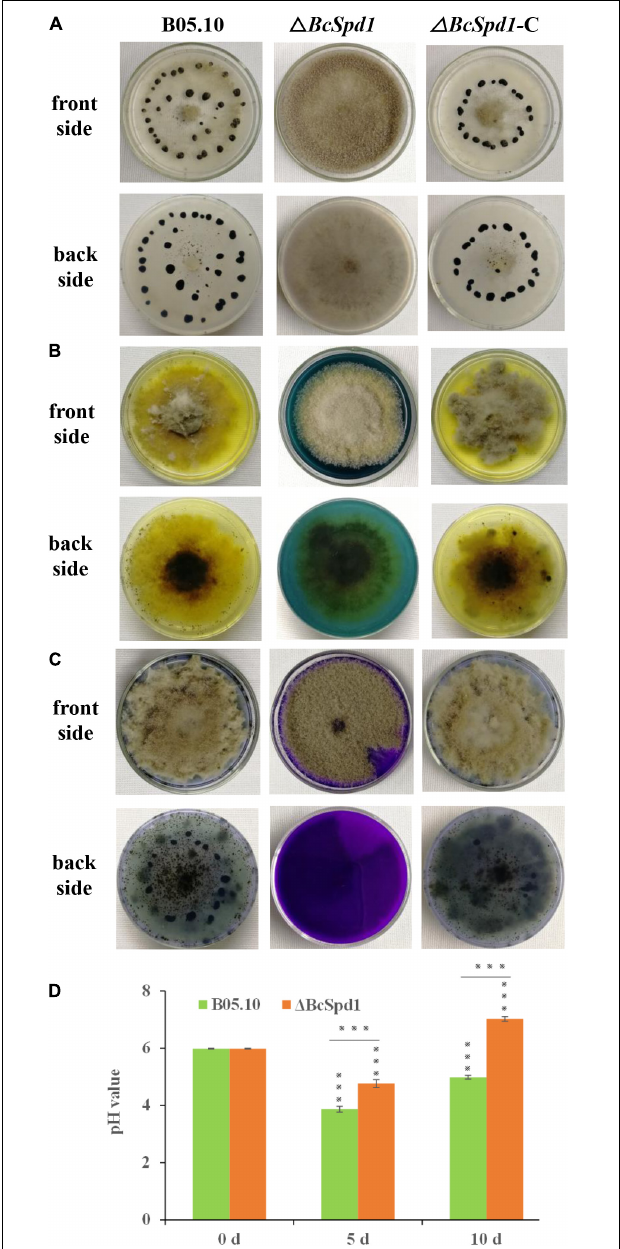
FIGURE 2 | Impact of BcSpd1 deletion on sclerotia development and organic acid biosynthesis. (A) Wild-type strain B05.10, (cid:49) BcSpd1 , and the complemented strain (cid:49) BcSpd1- C were incubated on CM plates at 25 ◦ C for 4 weeks in darkness. Both B05.10 and (cid:49) BcSpd1- C produce sclerotia on the plates, while (cid:49) BcSpd1 does not. (B) Indicated strains were incubated on CM plates with 0.1% bromophenol blue for 4 days. Both B05.10- and (cid:49) BcSpd1- C-incubated plates show yellow color, while (cid:49) BcSpd1 shows blue. (C) The indicated strains were incubated on CM plates with 0.1% bromothymol blue for 4 days. Both B05.10- and (cid:49) BcSpd1- C-incubated plates show weak blue color, while (cid:49) BcSpd1 show bluish violet. (D) pH changes in wild-type strain B05.10- and (cid:49) BcSpd1 mutant-incubated CM liquid mediums at different times (0 d, 5 d, or 10 d). The unincubated CM medium was used as control (CK). Asterisks indicate significant differences between treatments (*** P < 0.001, two-tailed t